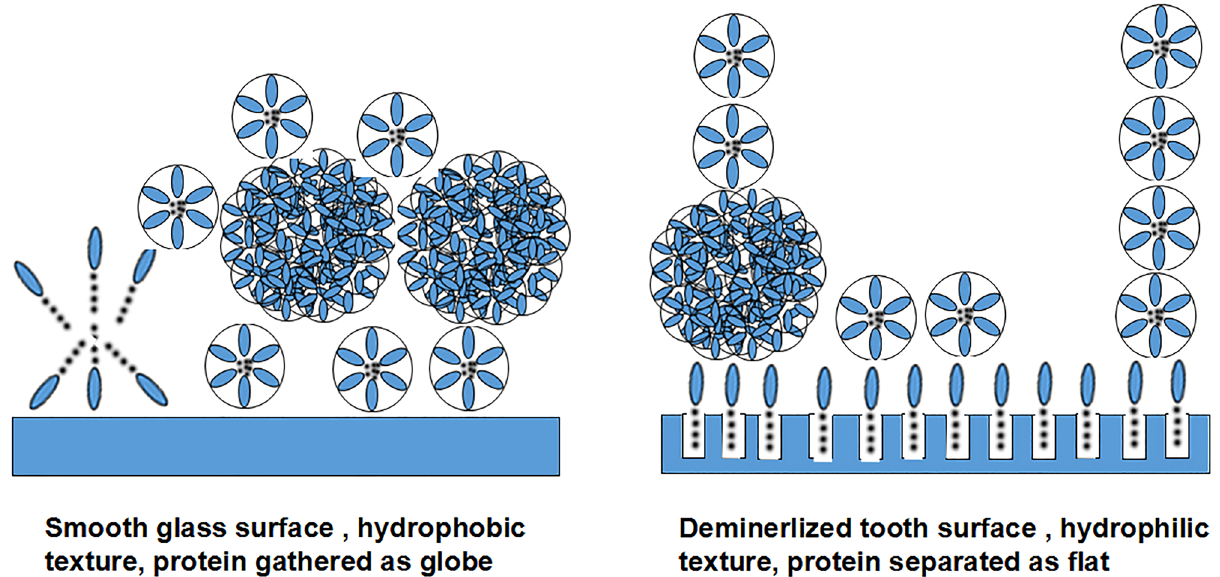
Figure 7. Suggested mechanism for crystal growth on normal glass and demineralized tooth. The smooth and hydrophobic surface of glass reduces interfacial energy and forms a single globe to “stand on”. The demineralized tooth surface presents hydrophilic features and deep groove, which allowed the insertion of the hydrophilic head of Am, leaving the hydrophobic domain to stick